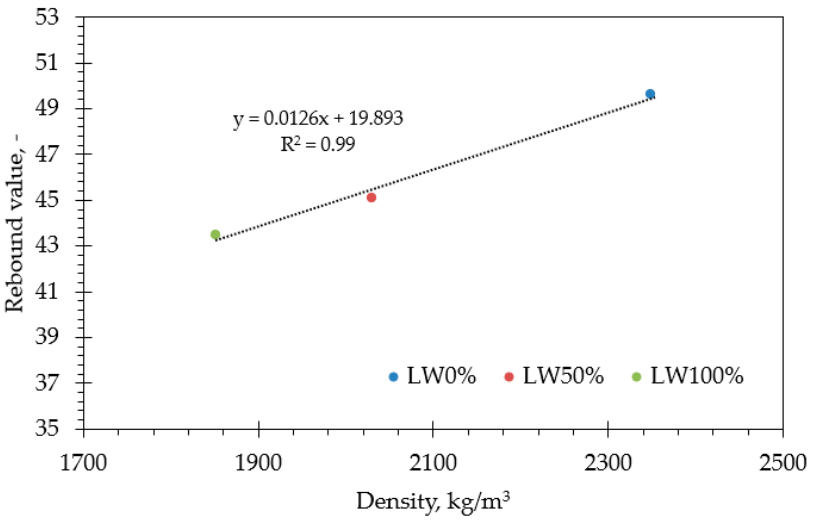
Figure 7. Figure 7. Correlation between rebound values and density of SCC produced with different LWA proportions.